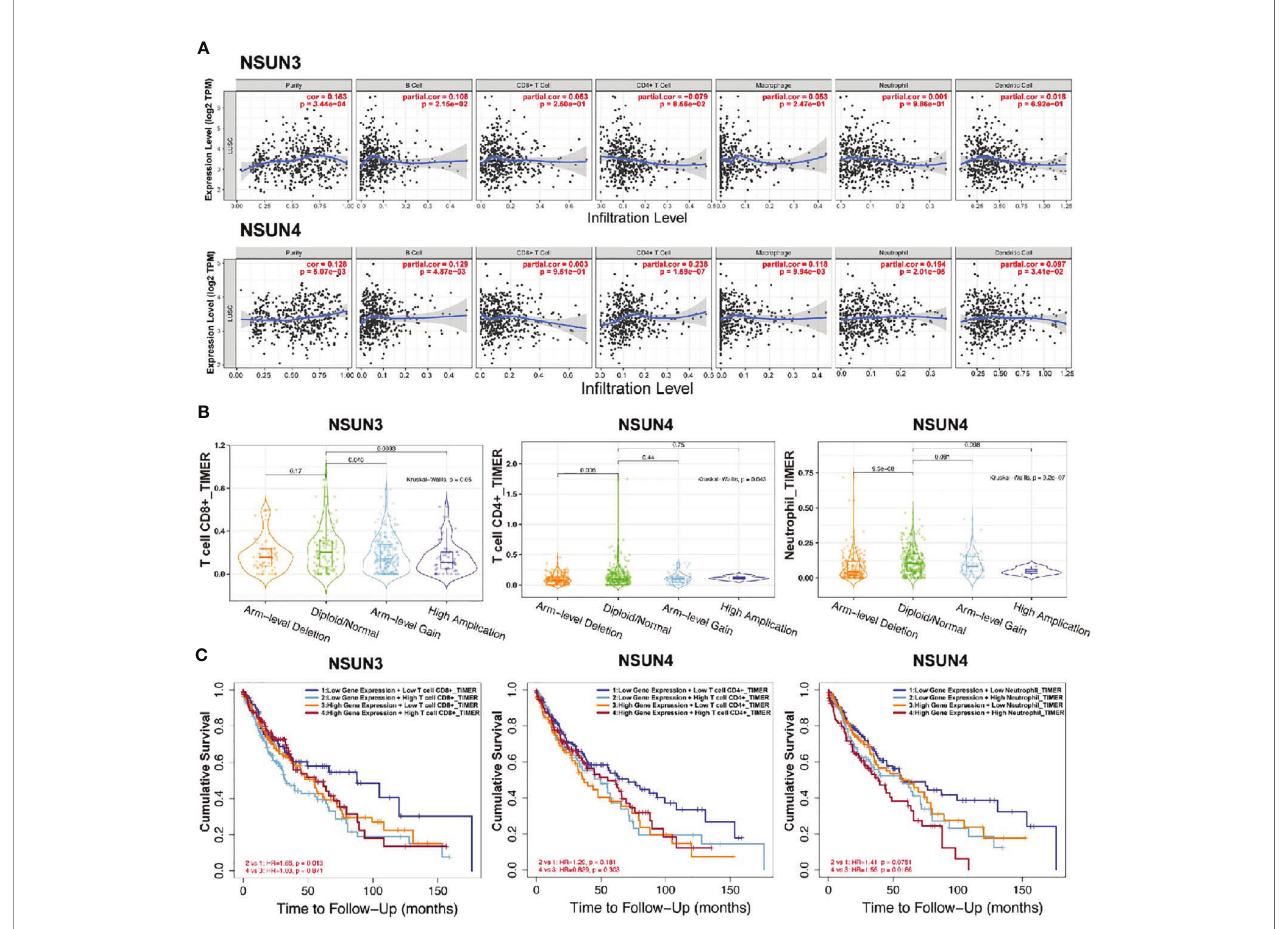
FIGURE 8 | Correlation analysis (TIMER) between m5CRNA methylation regulators and the in fi ltration levels of the sixmajor immune cells. (A) Correlation analysis of the in fi ltration levels of NSUN3 and NSUN4 and the six major immune cells after adjusting for purity. (B) Correlation analysis between somatic copy number alterations of NSUN3 and NSUN4 and the level of immune cell in fi ltration. (C) Survival analysis of combined NSUN3 and NSUN4 expression levels and immune cell in fi ltration